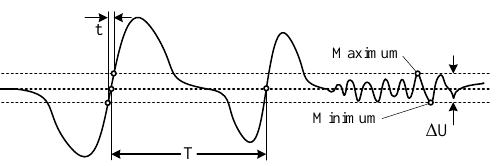
Figure 12. Evaluation of the frequency fluctuation according to the fluctuation amplitude of the lock-in amplifier output.